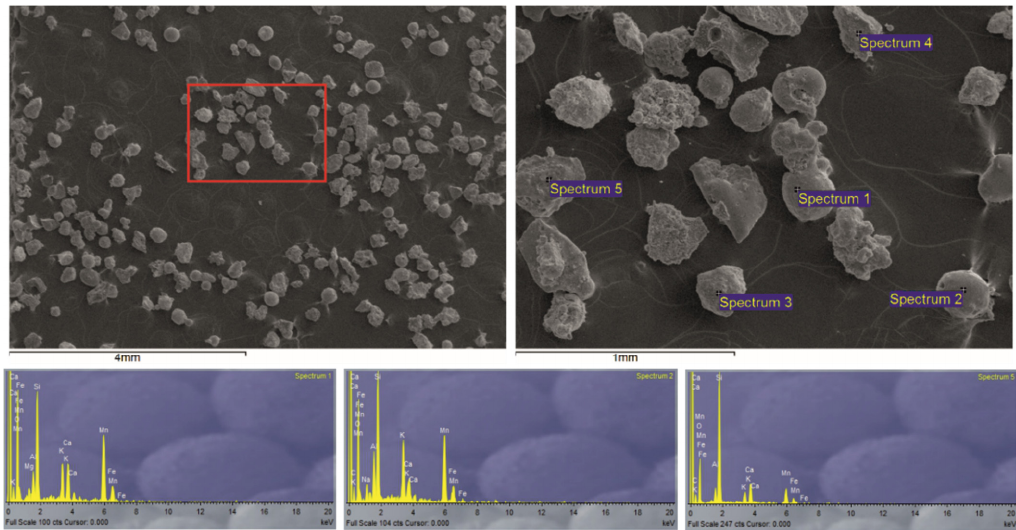
Figure 6. Backscattered electron images of the light dust fraction, and EDS spectra of the selected grains.